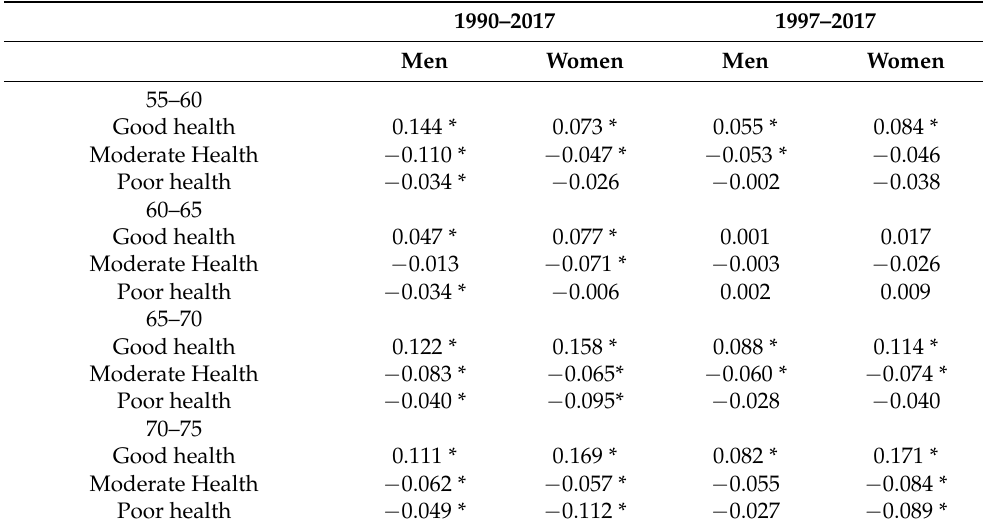
Table 2. Fitted growth rate for separate age categories for periods 1990–2017 and 1997–2017 (based on